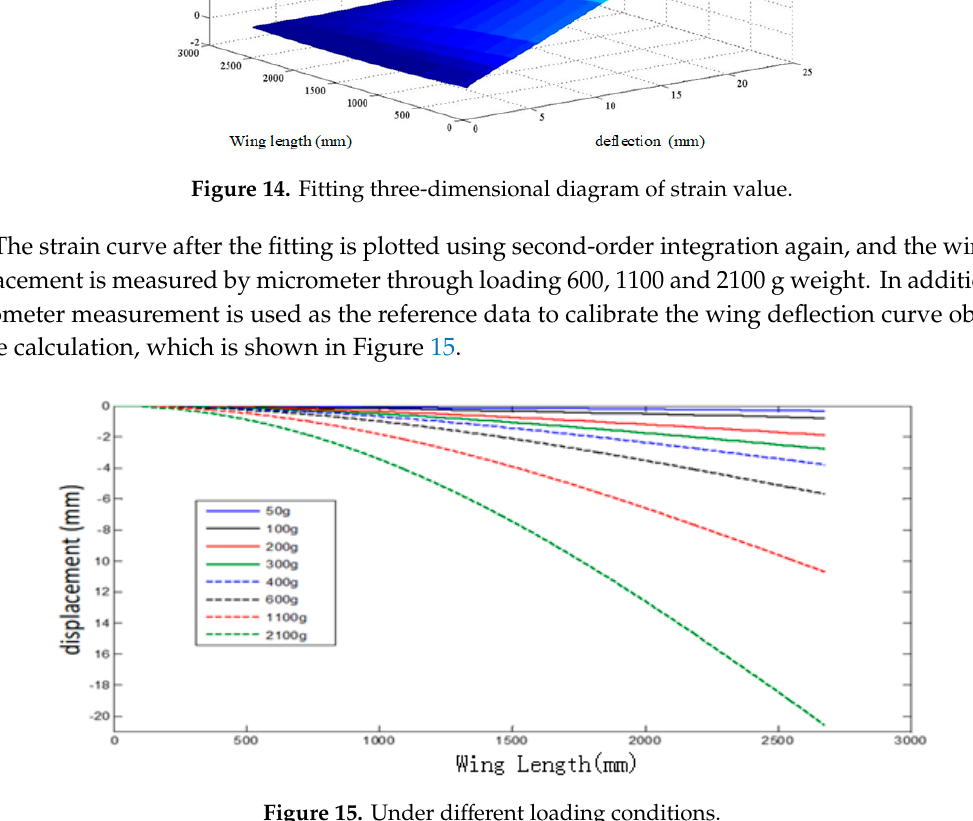
Figure 14. Fitting three-dimensional diagram of strain value.